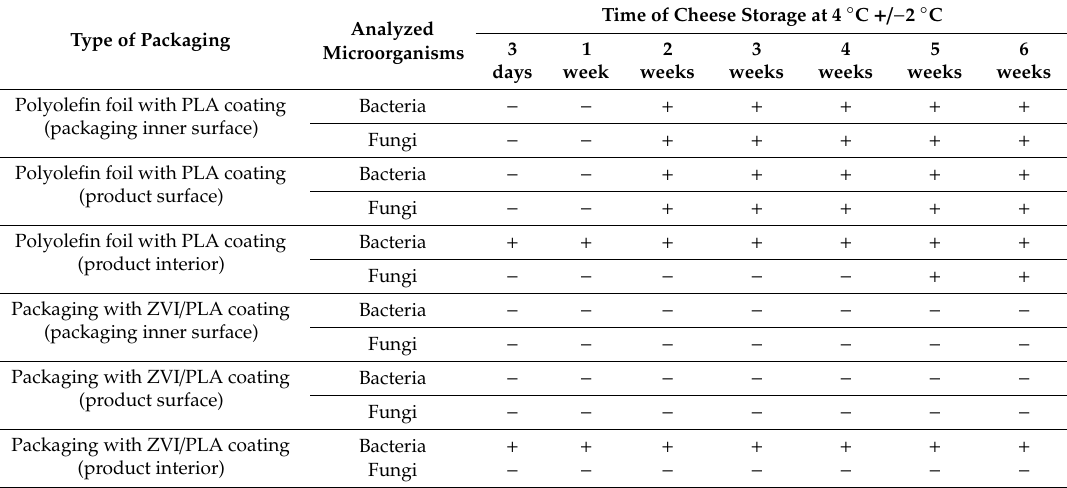
Figure 4. The test of antimicrobial activity of PLA films and PLA films with the addition of ZVI (1 or 3%), and FeO (3%) against E. coli ( a ) and G. candidum ( b ). Table 4. Antimicrobial activity of polyolefin film with 3% ZVI / PLA coating applied for wrapping goat cream cheese stored for 6 weeks at chilled